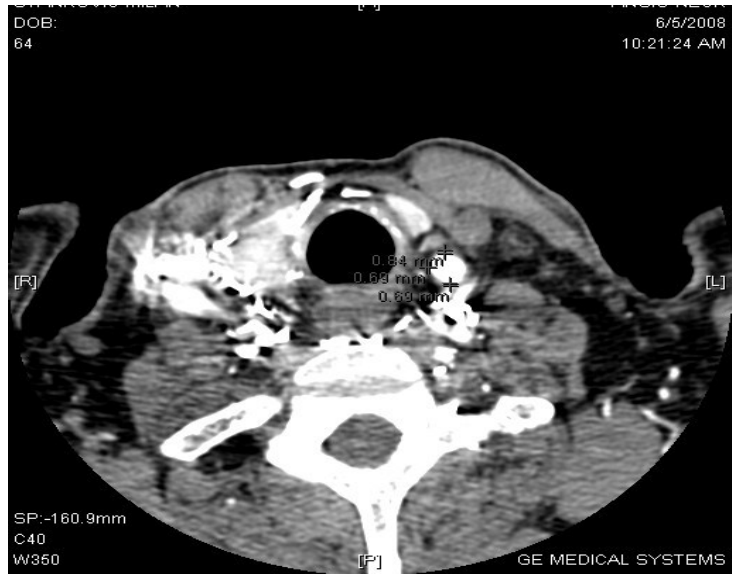
FIGURE 1 . MDCTA axial image of a 64-year-old male,